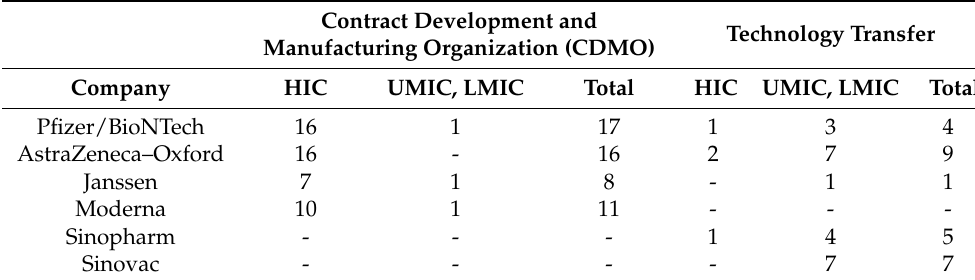
Table 6. Number of manufacturing agreements of EUL vaccine manufacturers. Contract Development